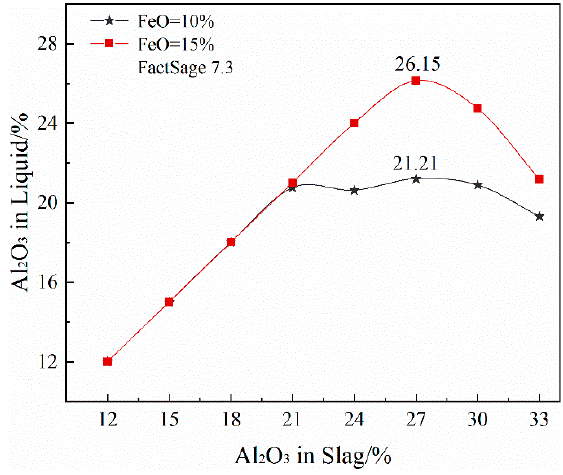
Figure 9. The solubility of Al 2 O 3 in liquid phase.